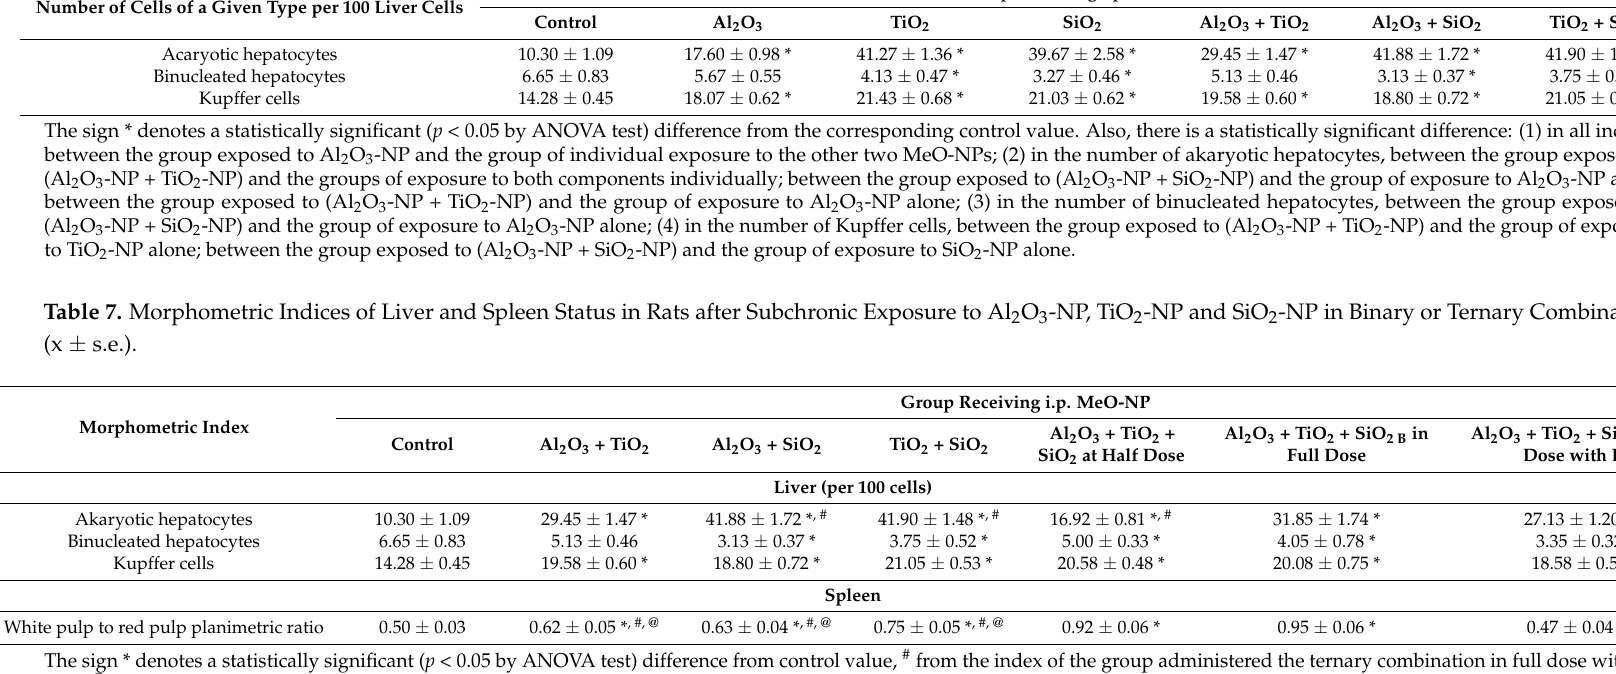
Table 6. Morphometric Indices of Liver Status in Rats after Subchronic Exposure to Al 2 O 3 -NP, TiO 2 -NP and SiO 2 -NP Individually or in Binary Combinations (x ± s.e.). Number of Cells of a Given Type per 100 Liver Cells